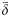
Reversible model.(A) The model includes the reverse recovery stroke (k-RS) and the reverse power stroke (k-PS). (B) The maximum work per ATP as a function of the distance parameter δ¯ (δa≡δ¯) and the connector stiffness K while other parameters have the optimal values.